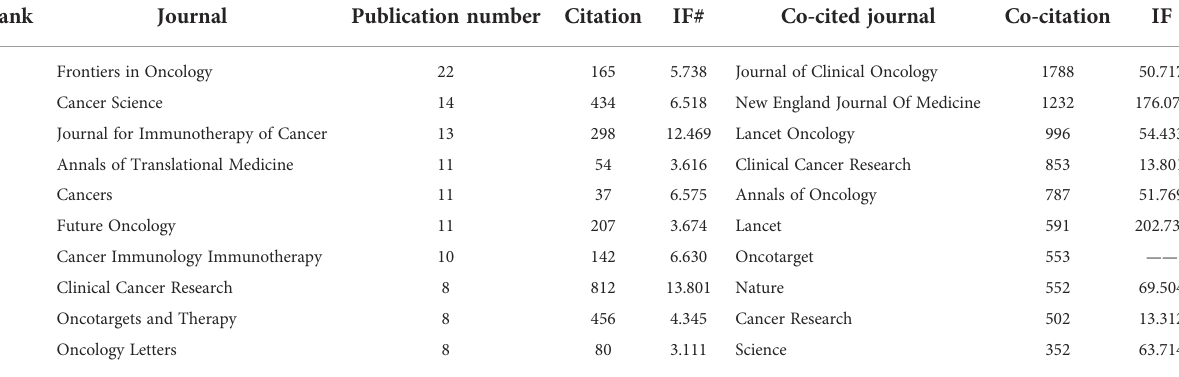
TABLE 3 The top 10 journals and co-cited journals on anti-PD-1/PD-L1 immunotherapy for esophageal cancer from 2012 to